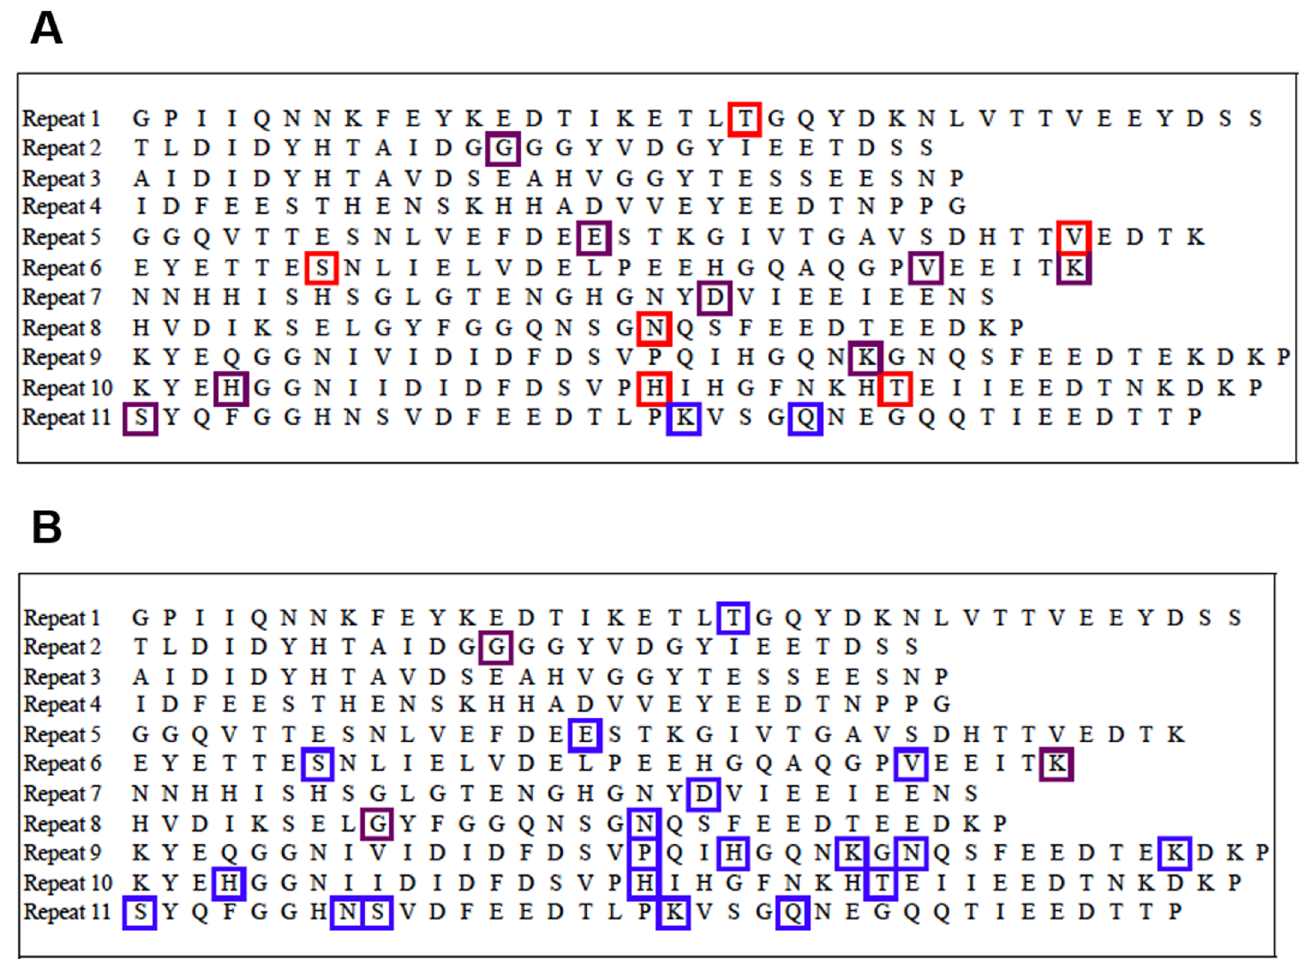
Fig 2. Single Nucleotide Polymorphisms (SNPs) in the binding regions (Repeats 1 – 11) of fibronectin binding protein A (FnBPA) in the derivation cohort (A) and external validation cohort (B). Red boxes indicate SNPs that were only present in isolates from the prosthetic joint infection group (PJI), blue boxes indicate SNPs that were only present in the uninfected (PJU) group, and purple boxes indicate SNPs that were present in both PJI and PJU